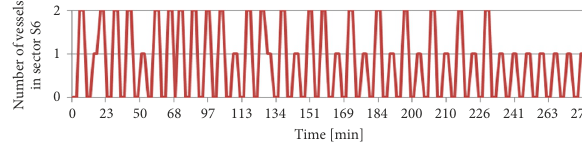
Figure 9. Number of crossing vessels in sector S6